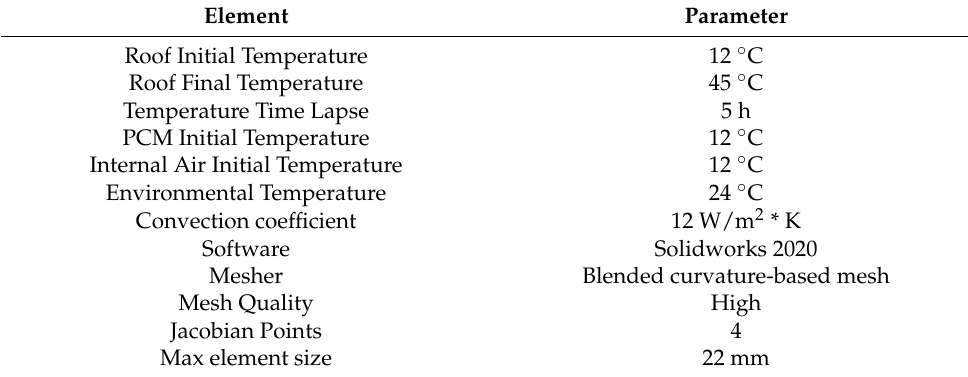
Table 3. Boundary conditions for charge.